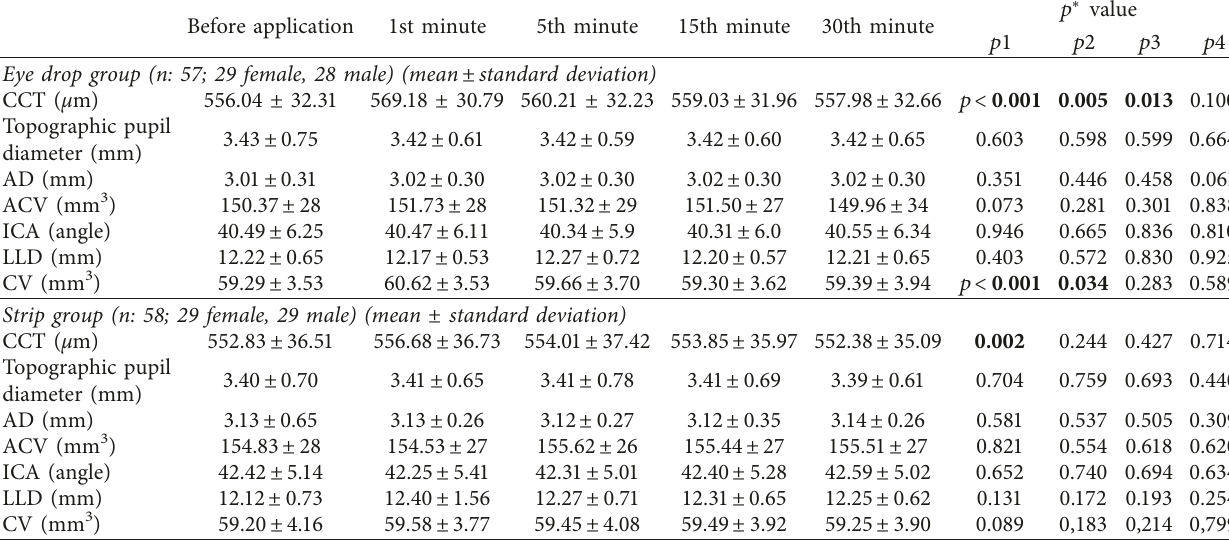
Table 1: Comparison of anterior segment parameter measurements in eye drop and strip groups. Before